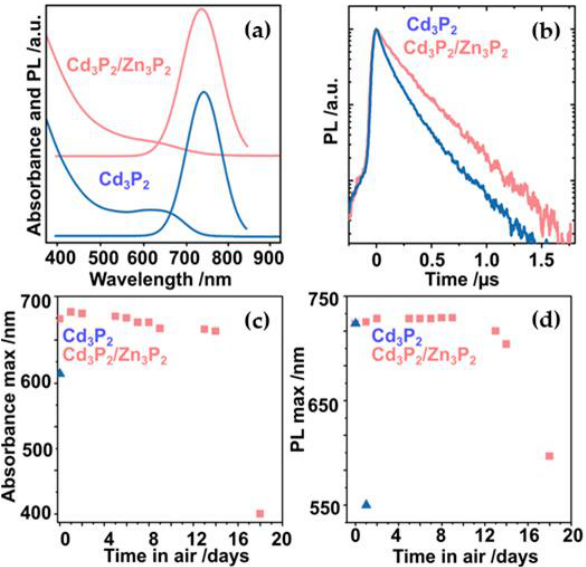
Figure 2. ( a ) Absorbance and emission of Cd 3 P 2 cores (blue) and Cd 3 P 2 /Zn 3 P 2 (red) core-shell NCs sealed in gas tight cuvettes under an Ar atmosphere. ( b ) Time-resolved emission spectra of Cd 3 P 2 cores (blue) and Cd 3 P 2 /Zn 3 P 2 (red) core-shell NCs ( c ) and ( d ) graph showing changes in absorbance and emission maxima of Cd 3 P 2 (blue triangles) and Cd 3 P 2 /Zn 3 P 2 (red squares) NCs upon exposure to air over a 16-day period.